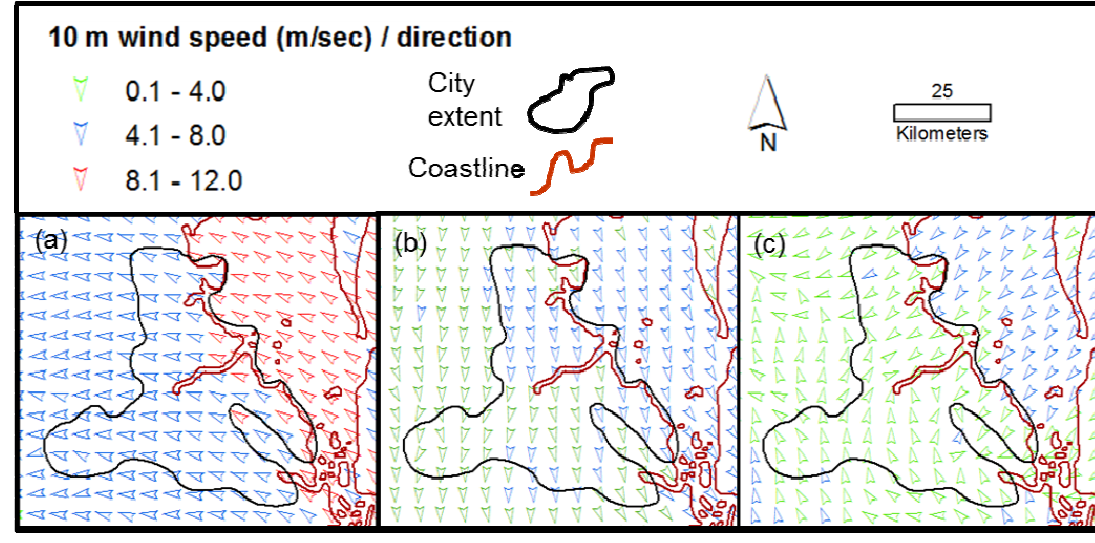
Figure 15. WRF wind speed and direction at 10 m above ground level for three rain events: ( a ) Sc2009, ( b ) Cu/Sc2010, and ( c )